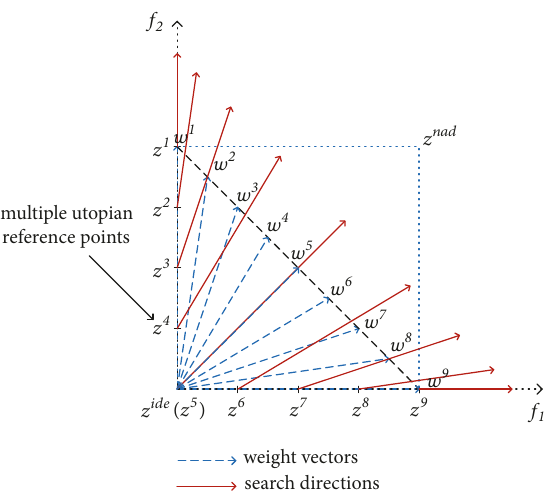
Figure 5: An illustration of correlation between a utopian point and its corresponding search direction for two objectives.